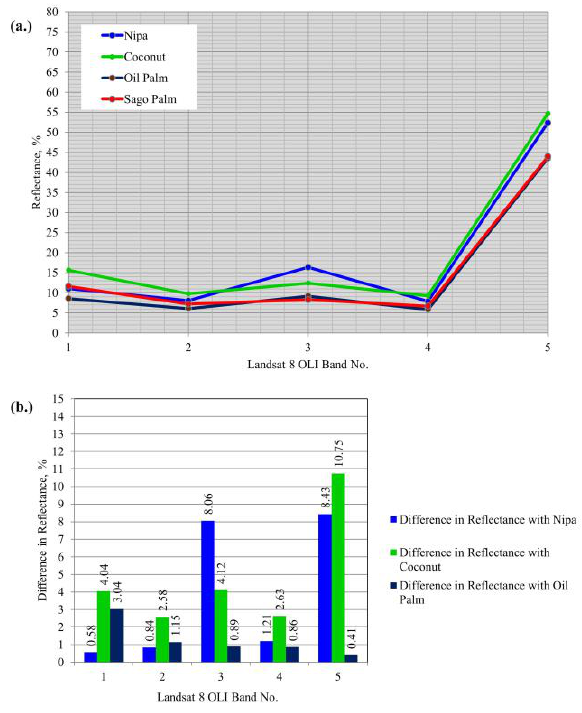
Figure 5. (a.) Resampled in-situ reflectance values of Sago and other palms in Bands 1-5 of Landsat 8 OLI; (b.) Difference in resampled in-situ reflectance of Sago with those of other